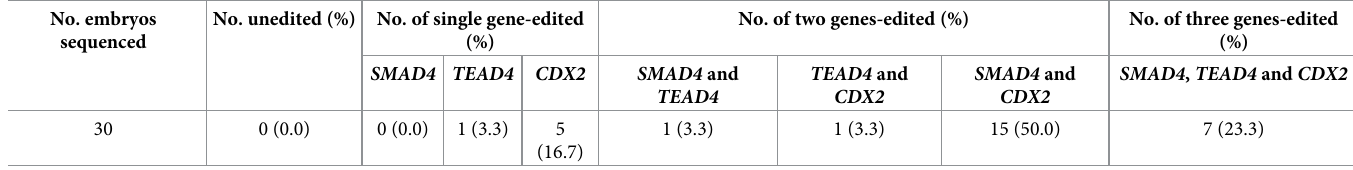
Table 2. Results of multiple genes’ editing in bovine embryos by ABE7.10. No. embryos